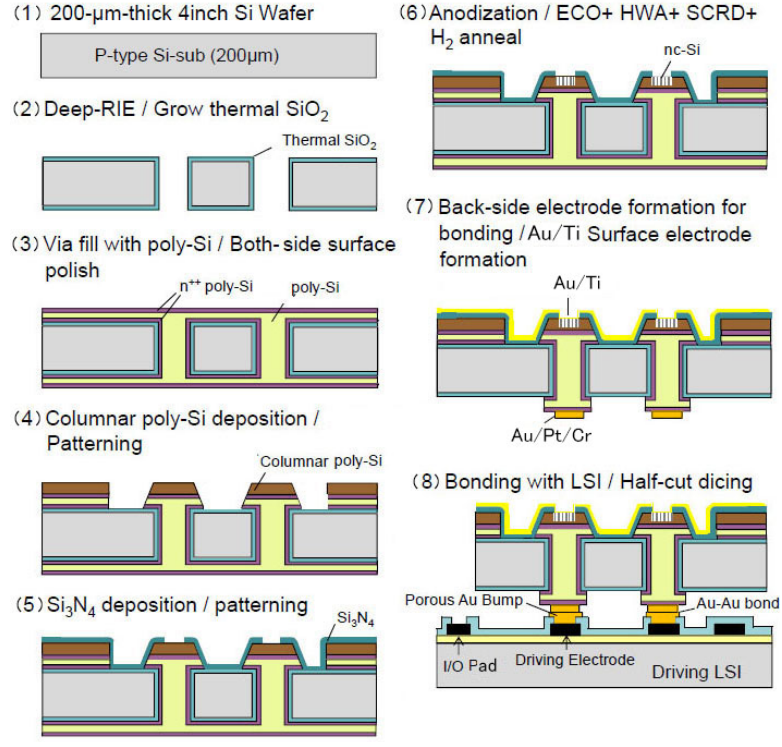
Figure 15. Fabrication process of planer-type active matrix electron source.